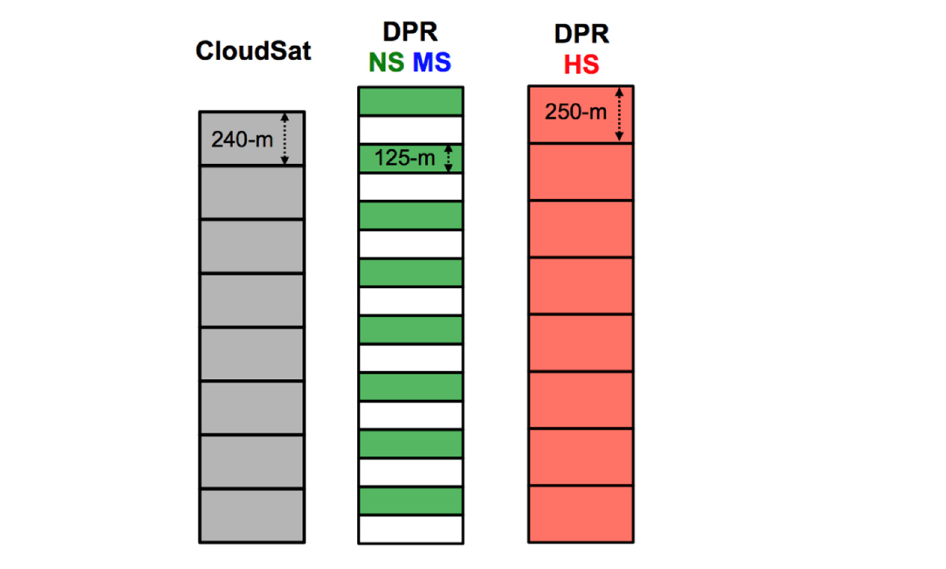
Figure 3. Depiction of nearest-neighbor bin matching. CloudSat is reported at 240-m vertical bin spacing, whereas at nadir DPR is reported at 125-m for the normal scan and matched scan, and 250-m for the high sensitivity scan. For each of NS, MS and HS, the “bin-matched” DPR bin is reported as the bin whose top lies just above the CloudSat bin top.